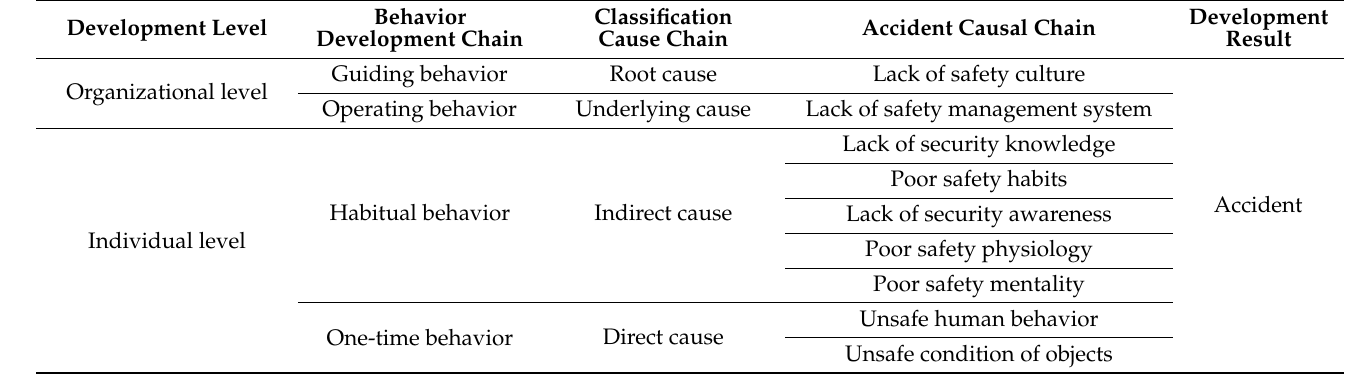
Table 1. Corresponding relationship between accident causes and